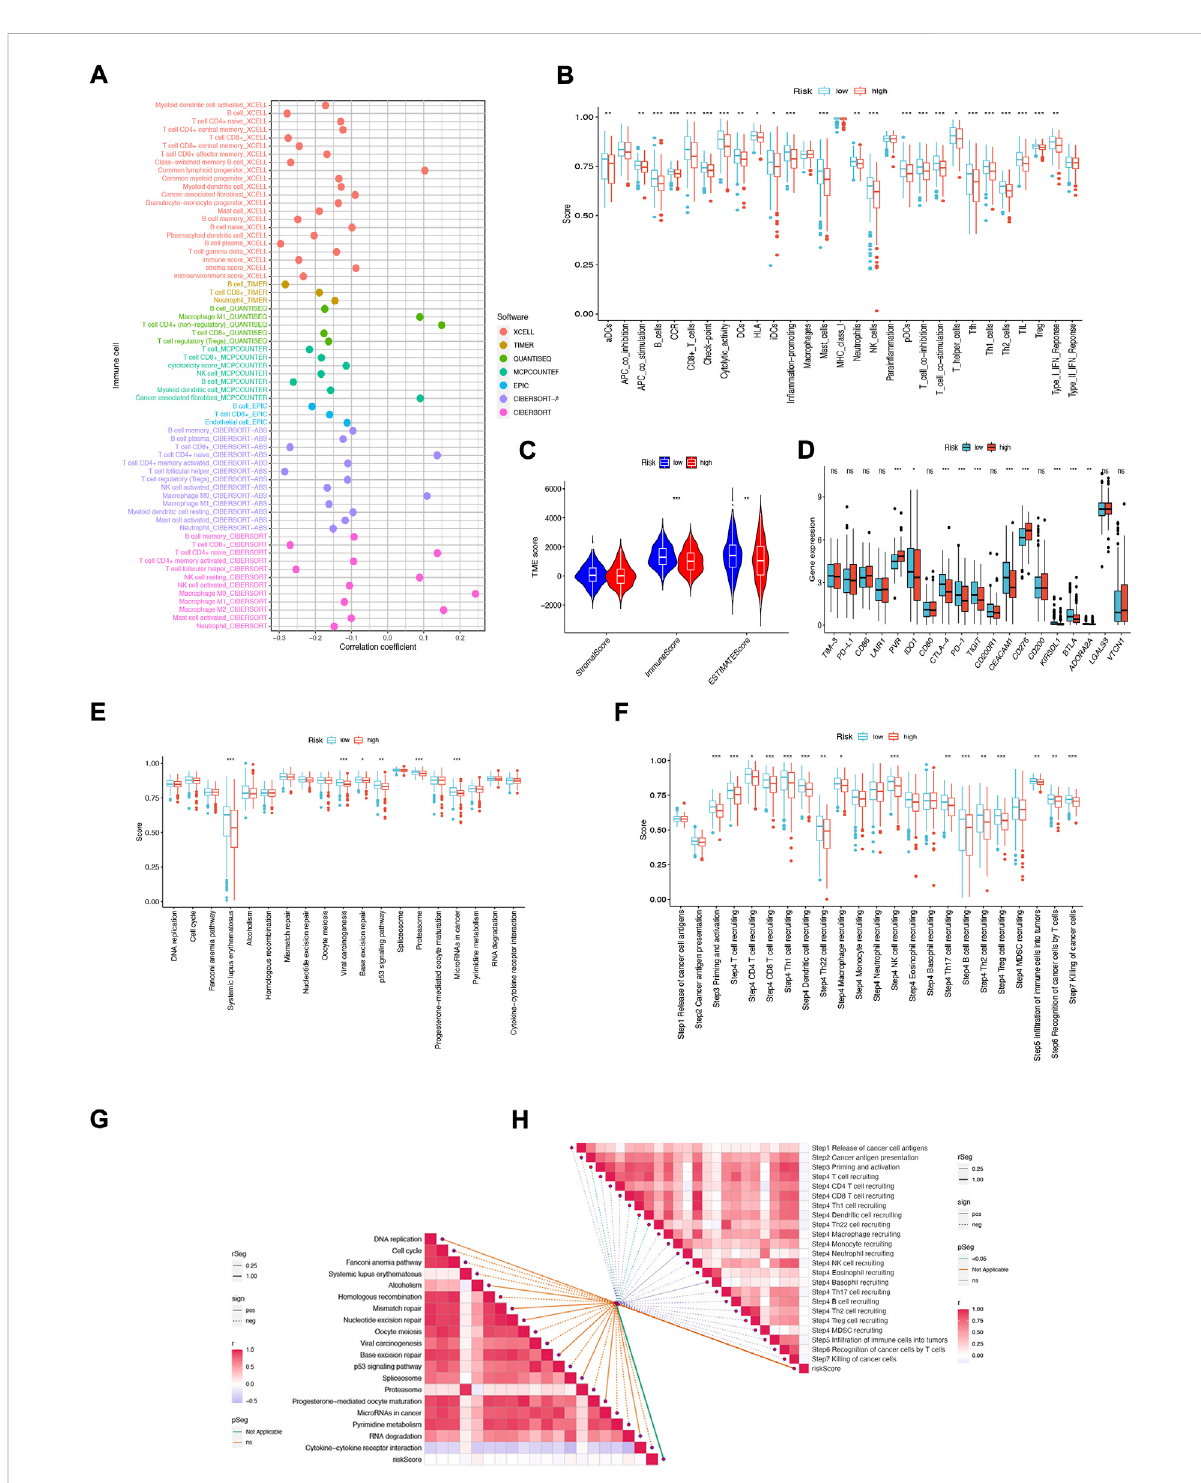
FIGURE 9 NFRGs risk score predicts tumor microenvironment and immune cell in fi ltration. (A) Immune cell bubble plots. (B) Immune cell and immune function ssGSEA scores between high and low-risk groups. (C) TME component analysis. (D) Immune checkpoint differences between high- and low-risk groups. (E) ICB response signature differences between high and low-risk groups. (F) Differences in immune steps with tumor between high- and low-risk groups. (G) Correlation between risk score and ICB response signature. (H) Correlation of risk scores with each step of the tumor immunization cycle. * p < 0.05; ** p < 0.01; *** p <